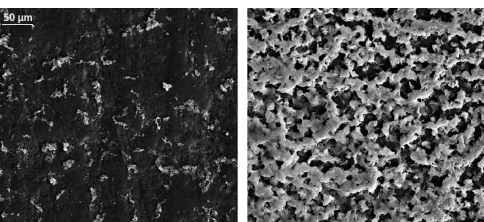
Figure A3. SEM image of Teflon surface for non-ESD ( left ) and ESD ( right ) scaled to 50 µm.